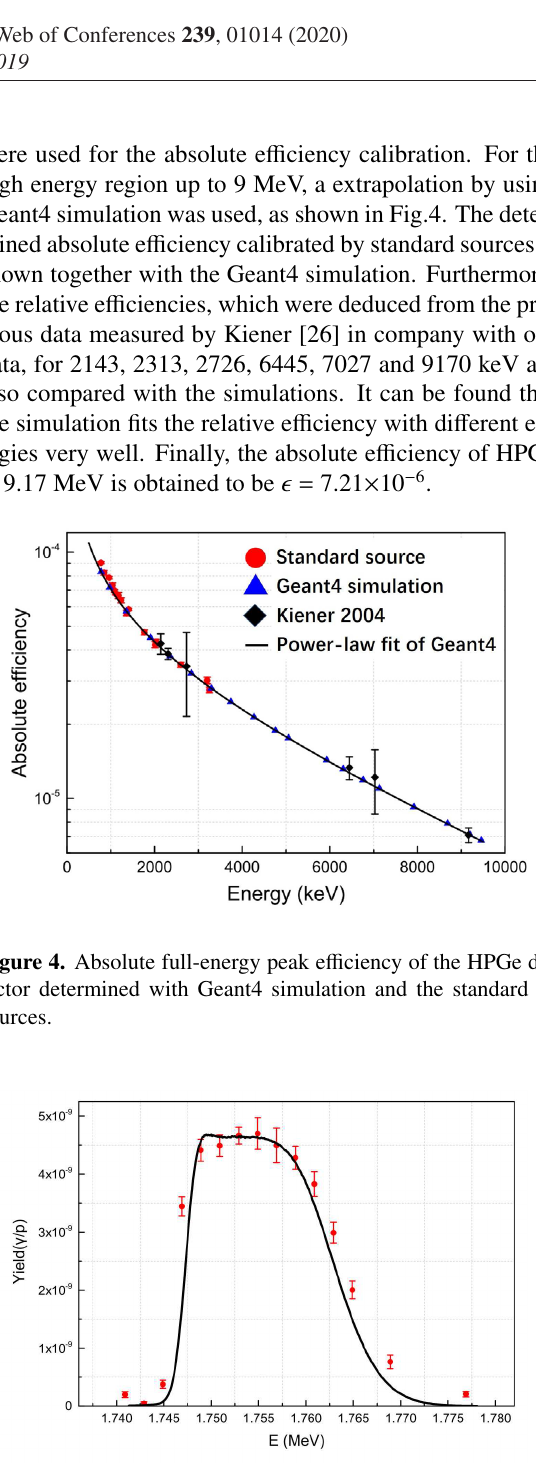
Table 1. Parameters of ( γ , n) reaction for 197 Au from two